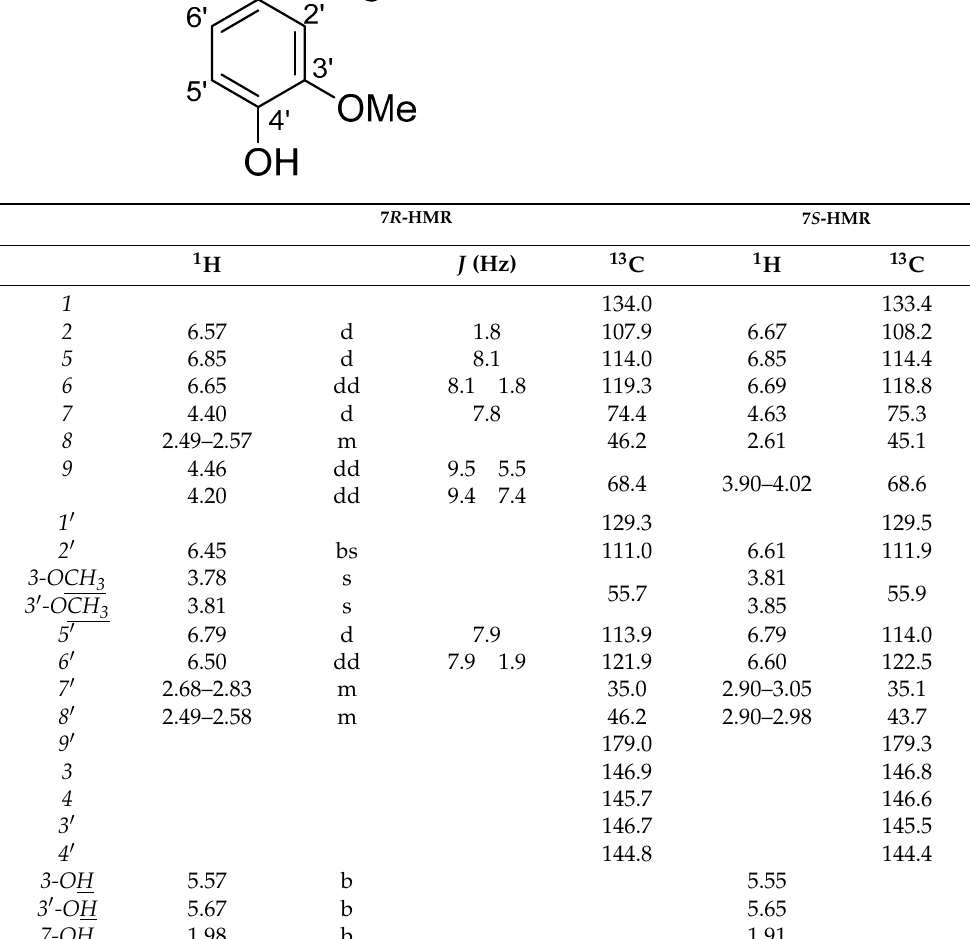
Table 2. NMR signal assignment for 7 R -HMR and comparison with 7 S -HMR chemical